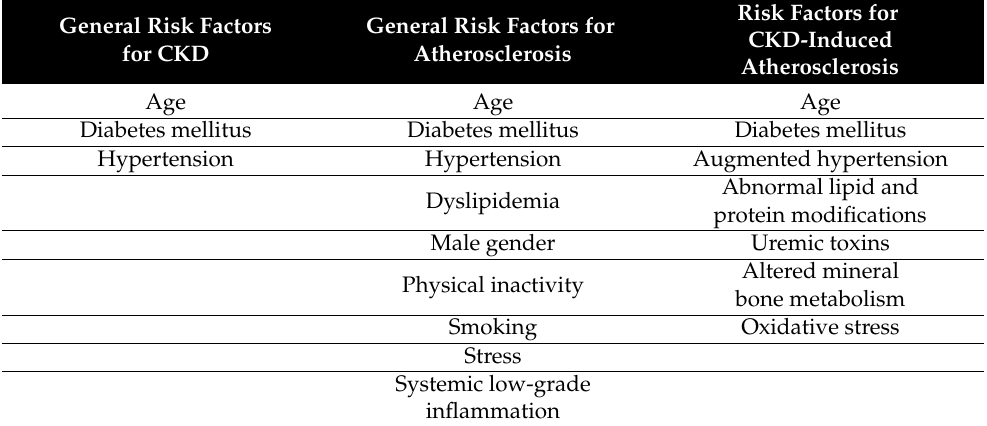
Table 1. Major risk factors specific for CKD, atherosclerosis, and CKD-induced atheroscl- erosis